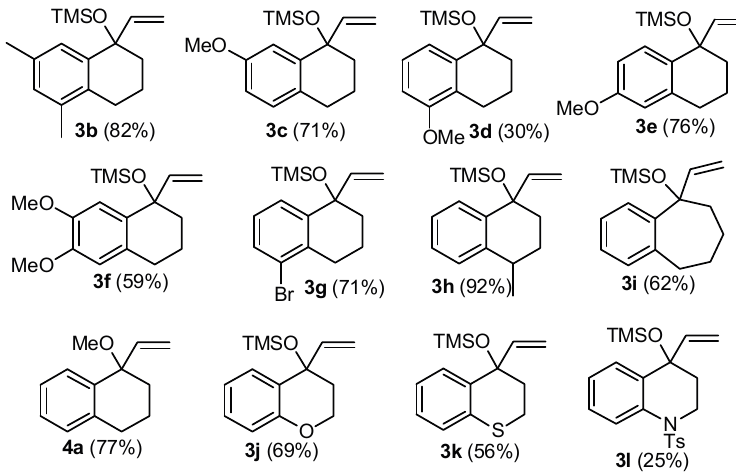
Figure 2. Structure of substrates 3b – l and 4a